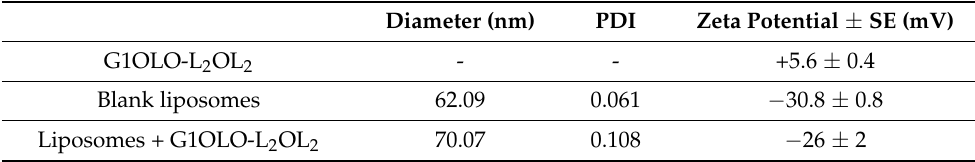
Table 1. Liposome and peptide characteristics: size, PDI, and zeta potential. Measures were made by triplicate.